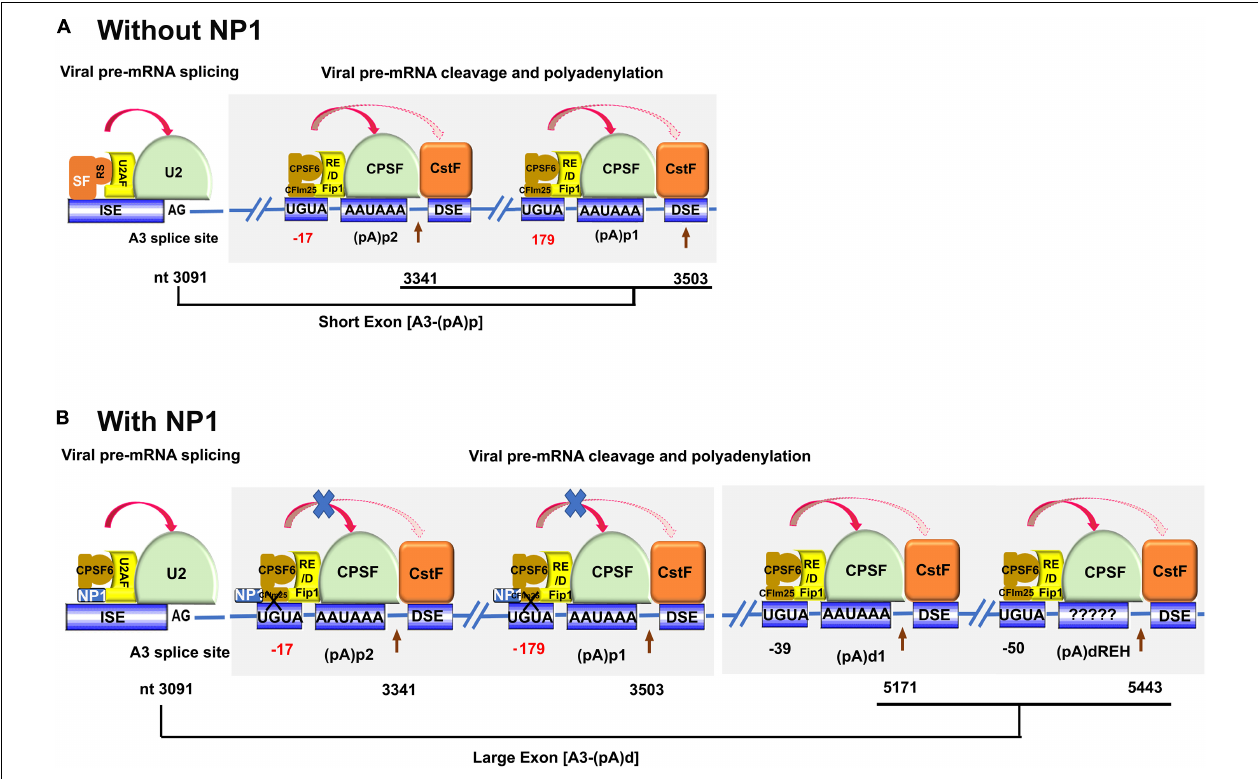
FIGURE 5 | A proposed model of NP1-facilitated definition of the VP-encoding exon. The viral pre-mRNA is shown in part with the A3 splice site, (pA)p1, (pA)p2, (pA)d1, and (pA)d REH sites. Key signals for mRNA processing, i.e., AG at the 3 (cid:48) acceptor, CFIm25-binding site UGUA, CPSF-binding site AAUAAA, are shown with the downstream element (DSE) indicated. The 3 (cid:48) acceptor U2 interacting complex (U2AF/U2 snRNP) and the CPSF complex composed of CFIm, Fip1, CPSF, and CstF are diagrammed. CPSF6 interacts with Fip1 through their RS and RE/D domains. Nucleotide (nt) numbers show the location of A3 3 (cid:48) splice site, and the cleavage site of each pA signals. (A) Without NP1. There are potential SR proteins (SF) binding to the A3 acceptor to enhance the binding of U2 snRNP to the A3 acceptor. CFIm binds to UGUA enhancers at 17 (too close) and 179 nts (too far) upstream of the (pA)p2 and (pA)p1, respectively. The distance between the A3 acceptor and (pA)p sites is short, which favors defining the exon between A3 and (pA)p sites. (B) With NP1. Potential interaction of NP1 with CPSF6 disrupts the interaction between CPSF6 and CFIm25 that binds UGUA sites 17 (too close) and 179 nts (too far) upstream of the (pA)p2 and (pA)p1, respectively. While the CFIm25 binds UGUA signals at –39 and –50 nt (optimal distance) upstream of the (pA)d1 and (pA)d REH , respectively, the interaction between CFIm25 and CPSF6 is tight and, therefore, difficult to be interrupted by the NP1. The overall interaction between the U2 snRNP complex at the A3 acceptor and the CPSF complex at the (pA)d sites determines the large exon between the A3 acceptor and (pA)d